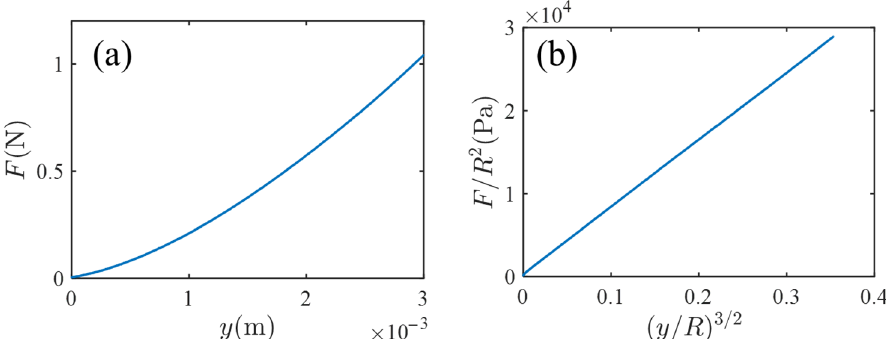
Figure 2. ( a ) A plot of the measured indentation force F versus indentation length y in the indentation experiment where a rigid spherical indenter is pushed against a thick gel disk. ( b ) The reduced plot based on the prediction of the Hertz contact theory.